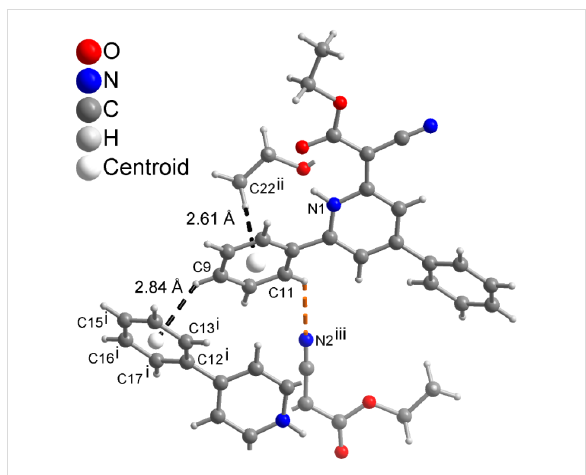
Figure 2: Supramolecular C–H···N [36-39] and C–H··· π [40-49] interac- tions around the 6-positioned phenyl ring in 5a . Details of C–H···N bond (dashed orange line) C11–H 0.95 Å, H···N2 2.61 Å, C11···N2 3.263(2) Å, C11–H···N2 127°. Symmetry transformations are i = 1 − x, 1 − y, 1 − z; ii = x, 3/2 − y, − 1/2+z, iii = 1 − x, − 1/2+y, − 1/2 − z.